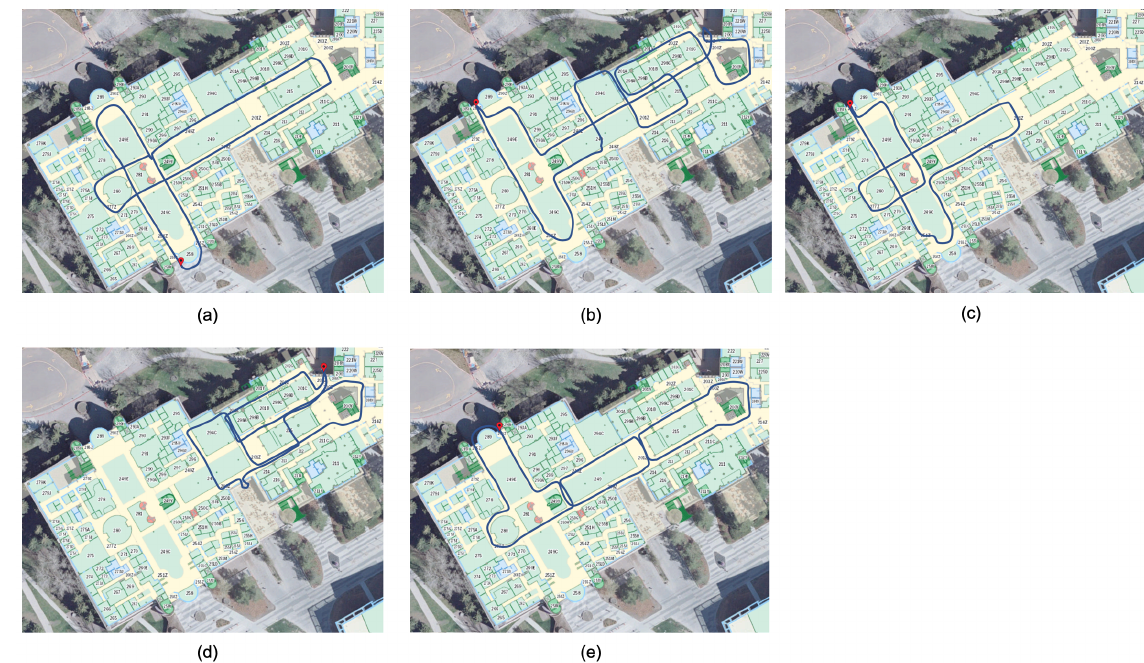
Figure 4. Training